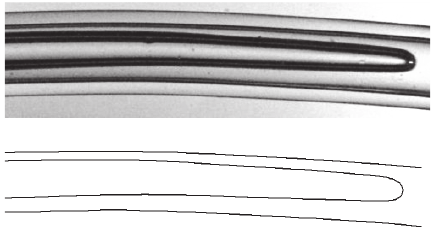
Figure 5: Bubbles image before and after processing.